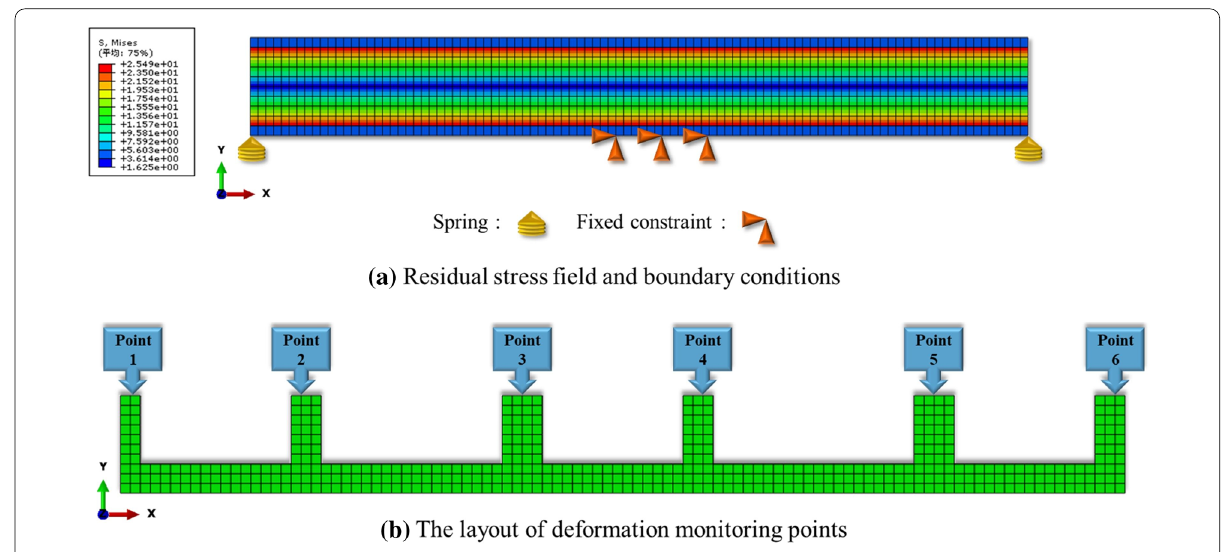
Figure 5 Simulation environment